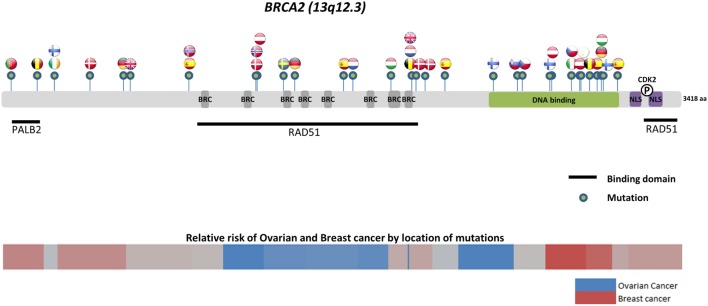
Location of common and founder BRCA2 mutations by country. Schematic of common and founder mutations by country modified from Janavičius (71) and Ramus and Gayther (72). Relative risk data taken from Rebbeck et al. (73).